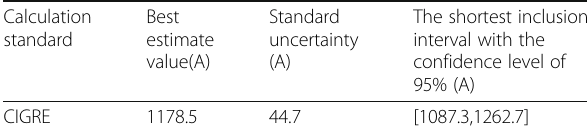
Table 6 MCM for solving DTR